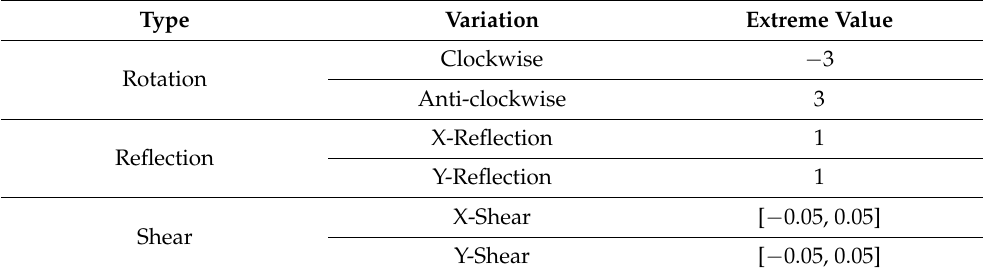
Table 2. Geometric distortions randomly applied to the dataset.